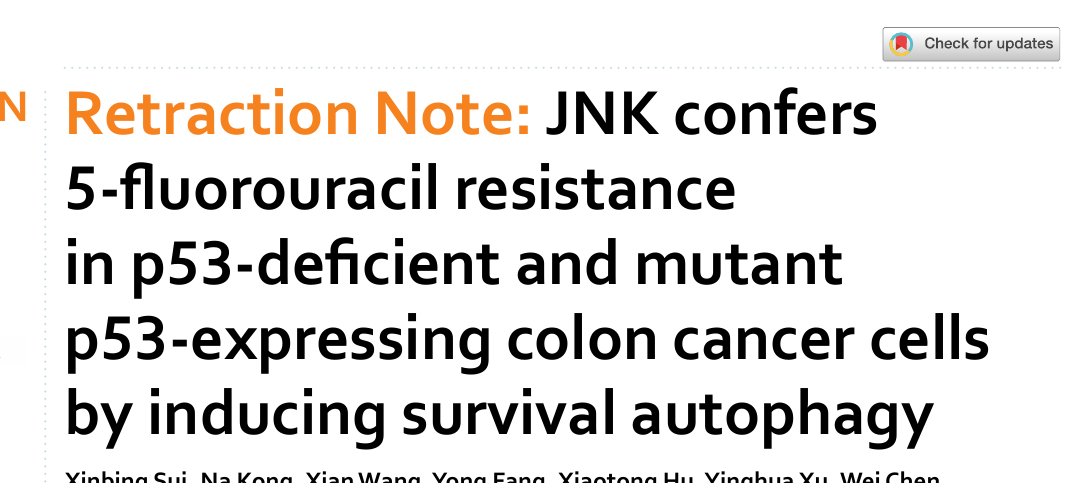
- Figure 1B: the HCT116 p53+/+ GAPDH band appears to be identical to the HT29 GADPH band for Figure 4A - Figure 1B: the hCT116 p53−/− GADPH band appears to be identical to the HCT116 p53+/+ GADPH band for Figure 4A - Figure 4A: the HCT116 p53+/+ p-JNK band appears to be identical to the band for RKO JNK - Figure 4B: the HCT116p53−/− control 5-FU(20mu) GAPDH band appears to be identical to the HT29 GAPDH band in Figure